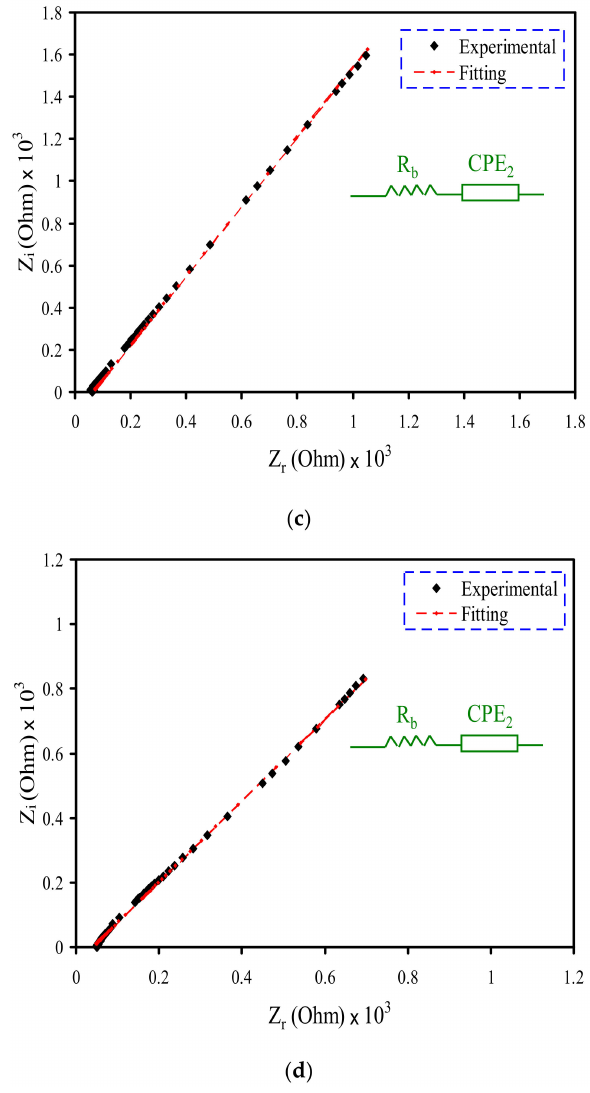
Figure 2. EIS plots for ( a ) PVSCGP0, ( b ) PVSCGP1, ( c ) PVSCGP2, and ( d ) PVSCGP3 electrolyte